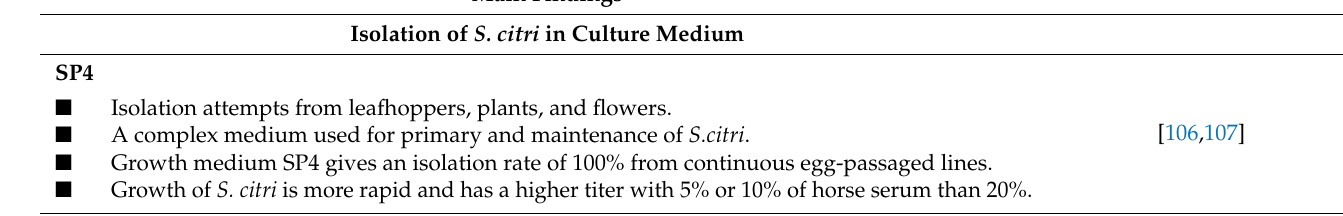
Table 4. Cont. Tested